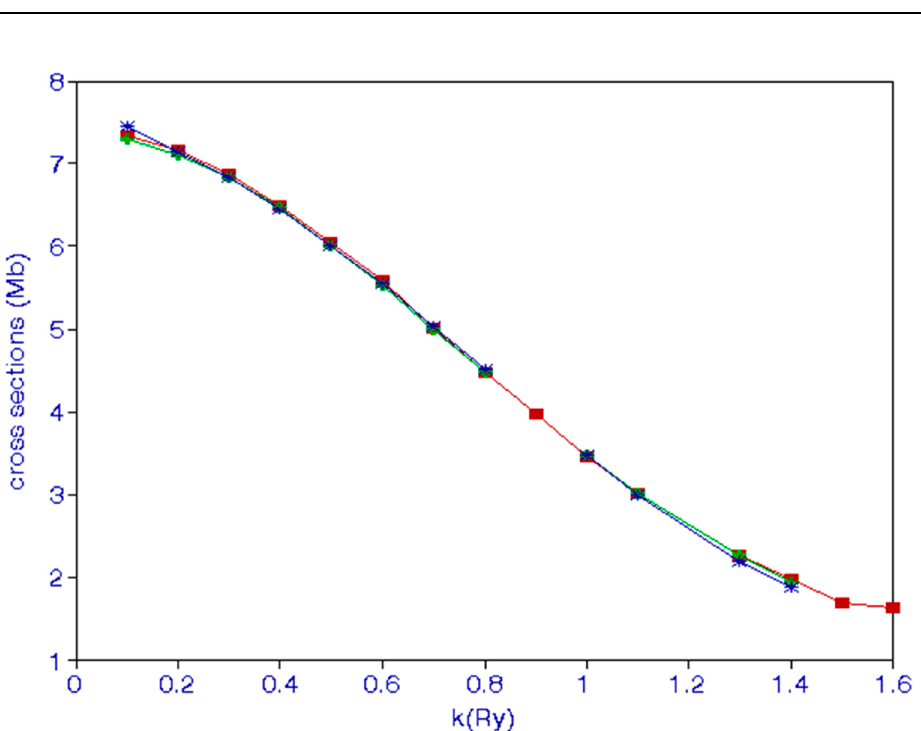
Figure 2. Photoionization of He. A comparison of cross sections calculated using the hybrid theory [8] and R -matrix approximation [16] with the experimental results [17,18] is